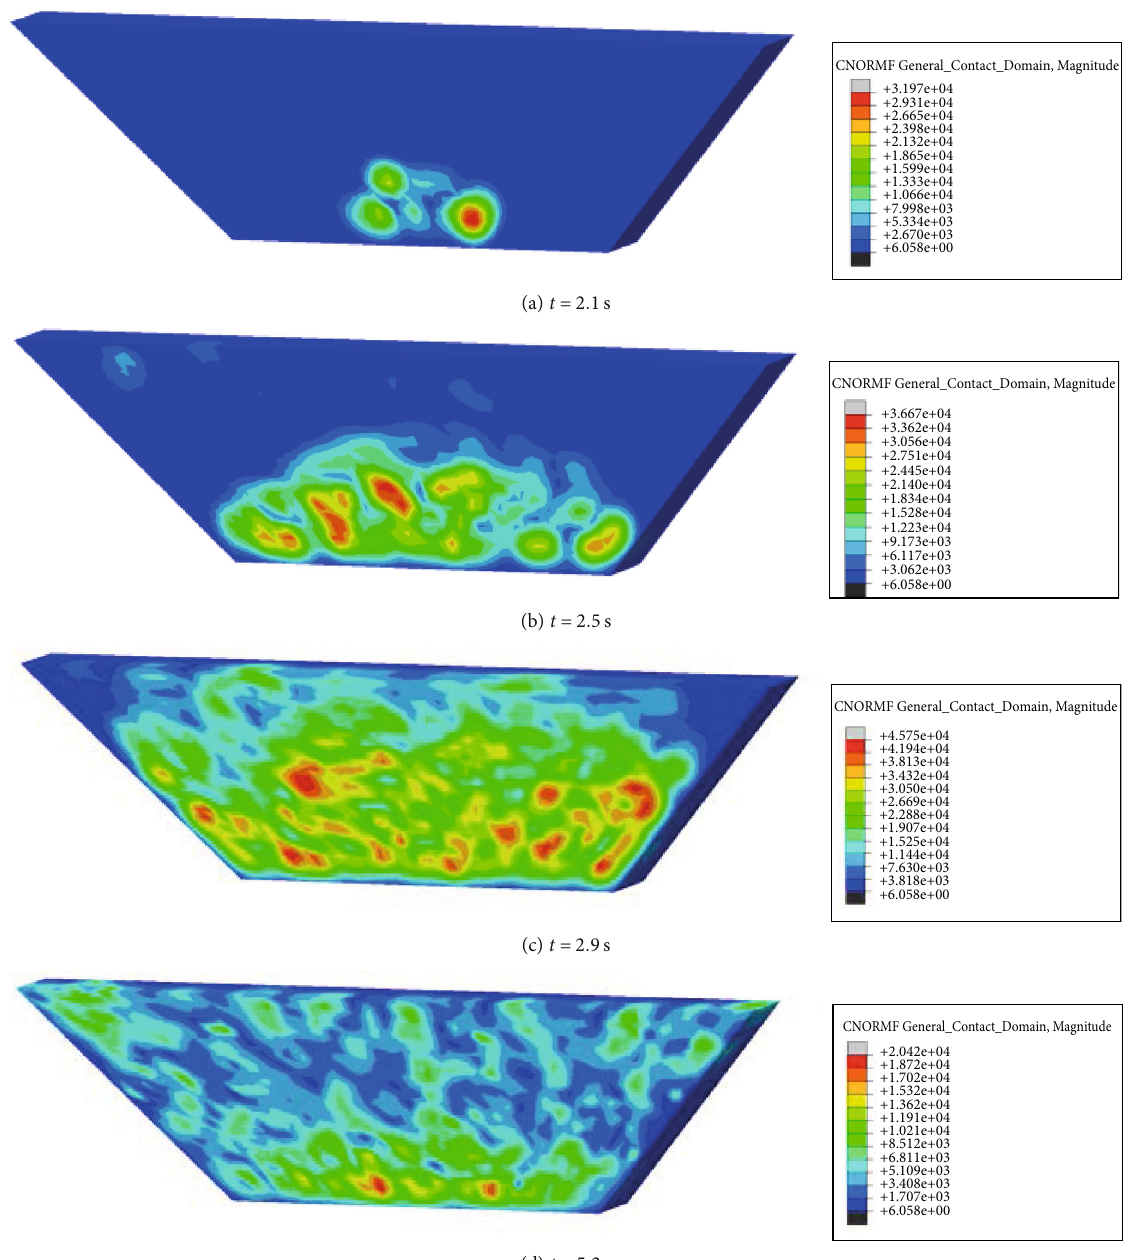
Figure 9: Impact force